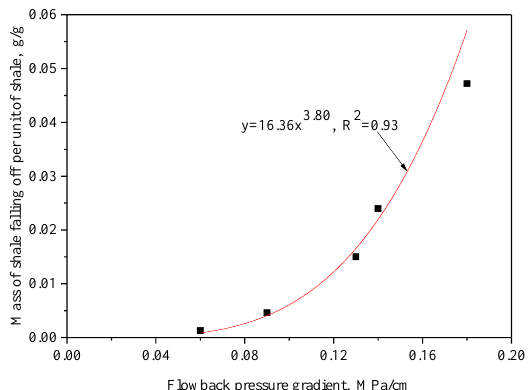
Figure 15. Flowback pressure difference and amount of shale particles dropped per unit mass shale.